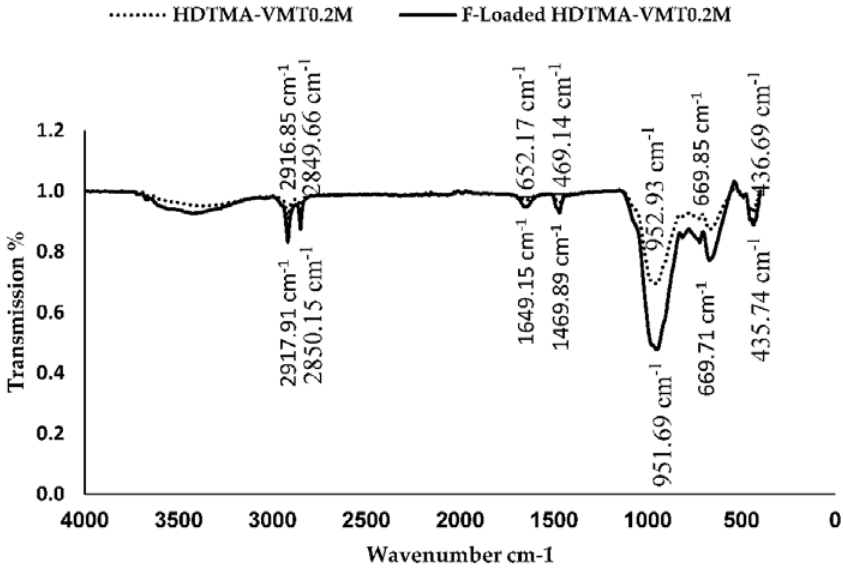
Figure 3. Fourier transform infrared (FTIR) analysis of HDTMA-VMT 0.2M before and after defluoridation.